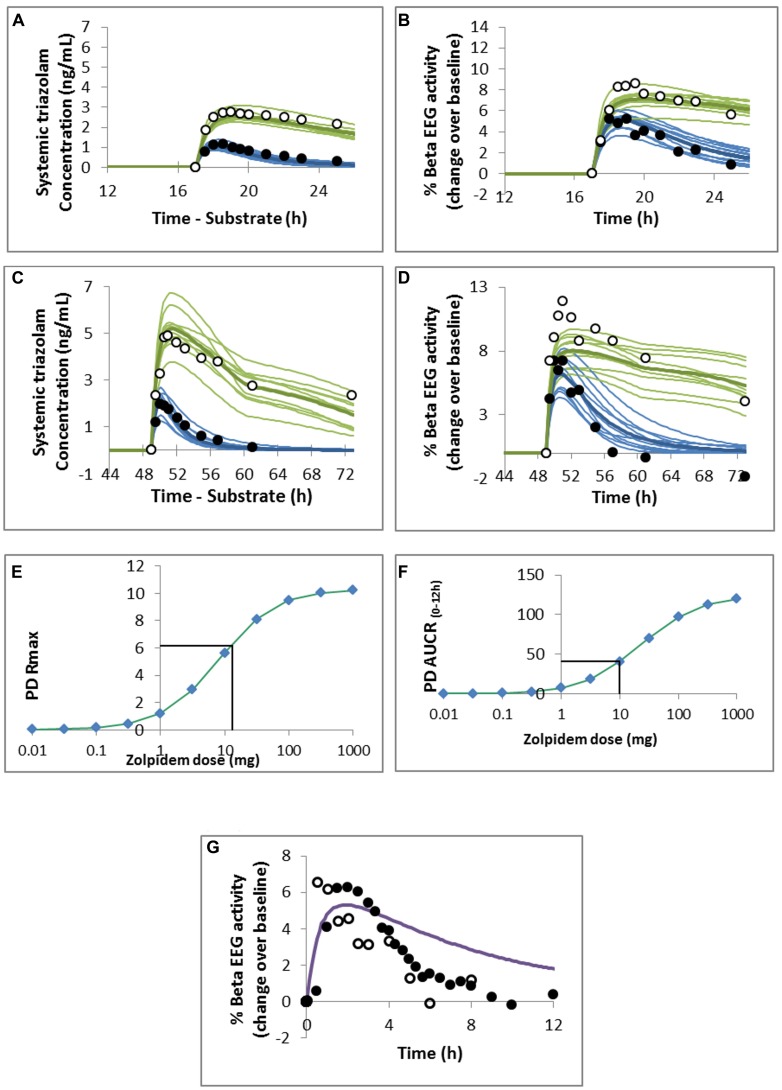
Predicted and observed (A,C) triazolam plasma concentration profile and (B,D) pharmacodynamic response to (A,B) 0.125 mg or (C,D) 0.25 mg oral triazolam in the absence (closed circles and blue lines) or presence (open circles and green lines) of ketoconazole. Observed data are from (A,B)
von Moltke et al. (1996) and (C,D)
Greenblatt et al. (2000) and the simulated study designs were matched to these studies. Predicted maximal observed response (PD Rmax; E) and area under the response curve (AUCR0-12; F) for a range of doses of oral zolpidem. The mean value of the response measure for 0.25 mg oral triazolam is indicated by the horizontal black line and was used to estimate the dose of zolpidem resulting in the equivalent measure of PD response. (G) Predicted mean PD response to 10 mg oral zolpidem. Observed data points are from Greenblatt et al. (2000; closed circles) and Greenblatt et al. (2006; open circles).